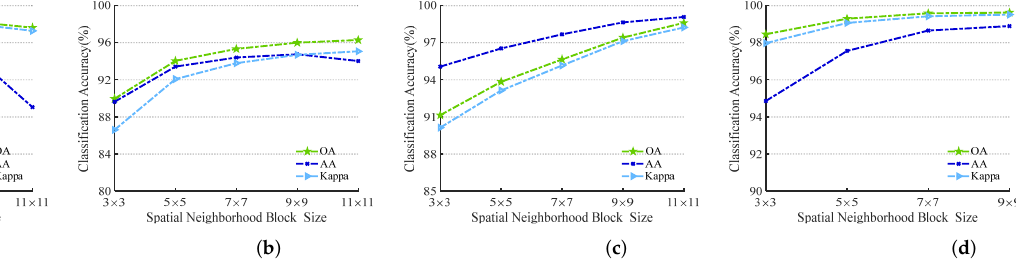
Figure 11. The impact of input spatial neighborhood block size on network performance. ( a ) Indian Pines dataset. ( b ) Universit of Pavia dataset. ( c ) Salinas dataset. ( d ) Long Kou dataset.